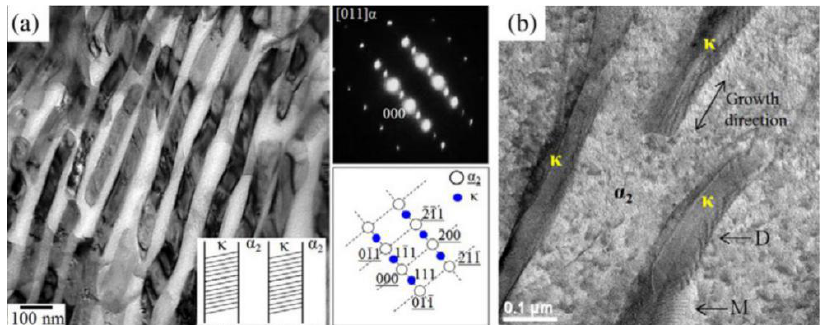
Figure 4. ( a ) TEM micrograph and the corresponding SADP of [011] α zone for the steel isothermally annealed at 600 °C and ( b ) Cs-corrected (S) TEM bright-field image. D, dislocations. (Reprinted with permission from [59], copyright Elsevier, 2013).